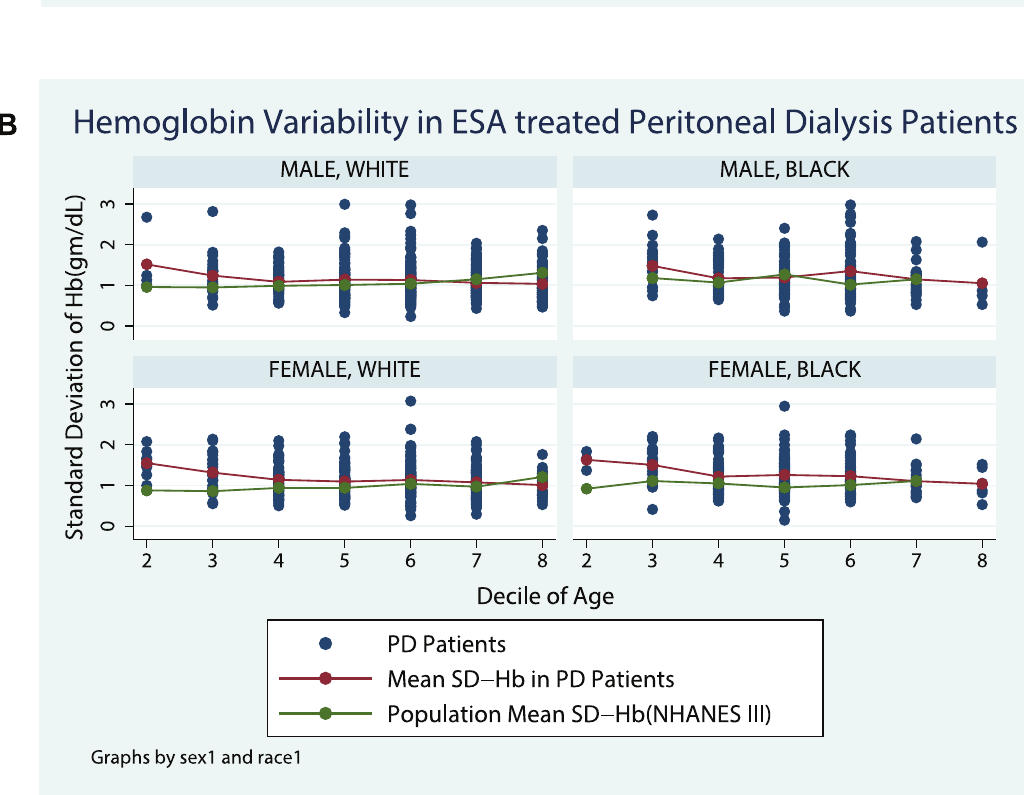
Figure 2. Hemoglobin Variability in ESA treated Peritoneal Dialysis Patients.